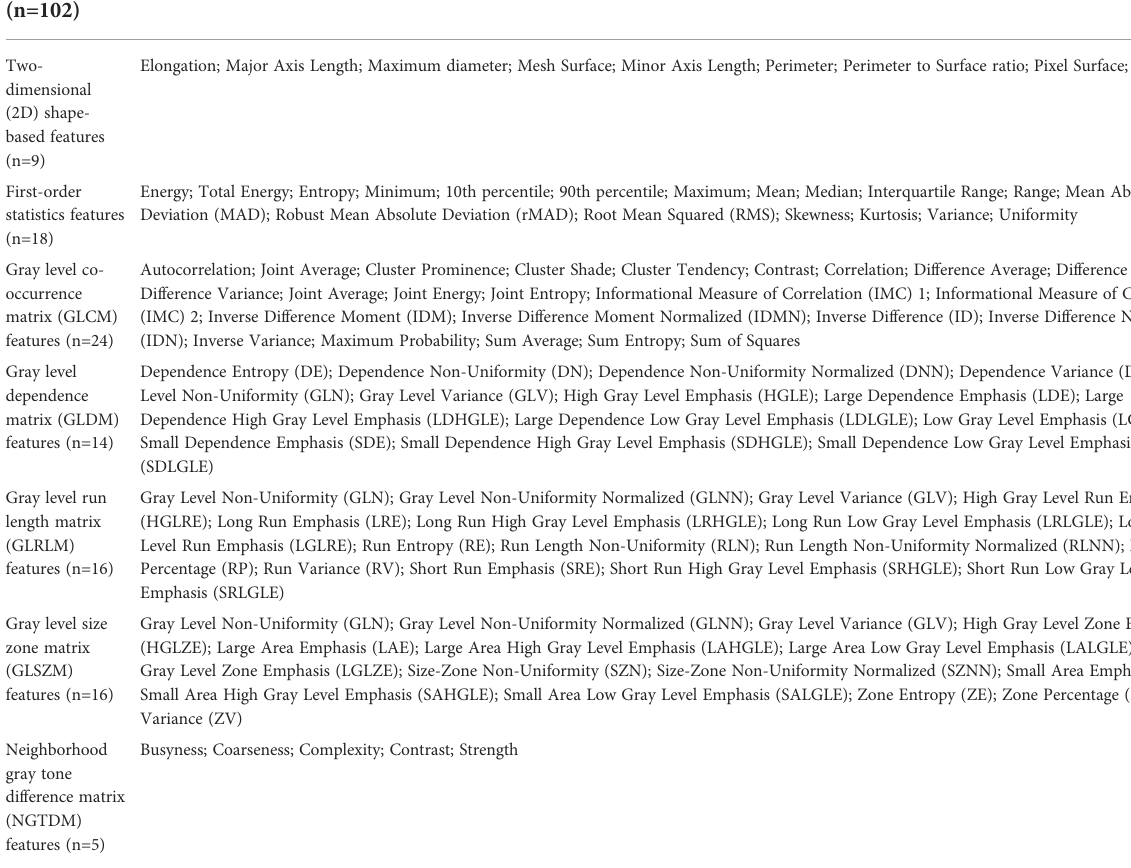
TABLE 1 Original radiomics features extracted in current